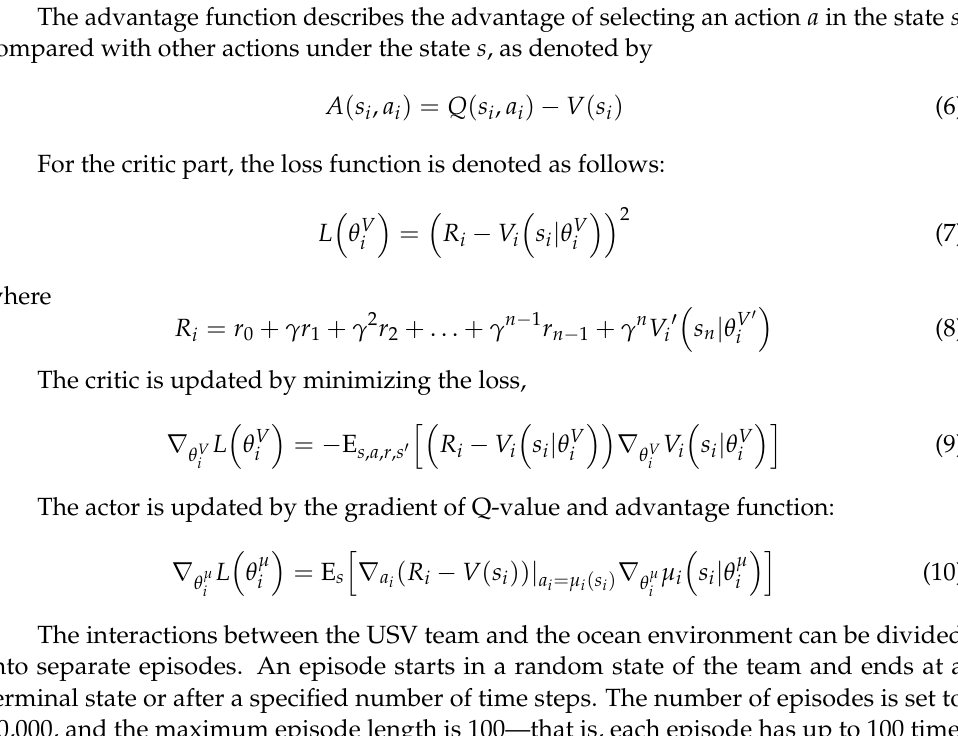
Figure 4. The network structure of each USV’s policy.